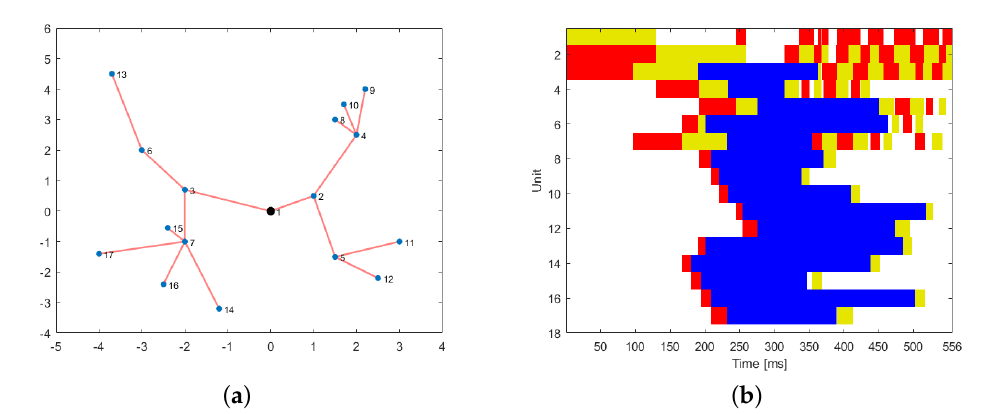
Figure 2. Scheduling example on a simple network. ( a ) Simple network with 17 nodes. ( b ) Scheduling example on one cycle.